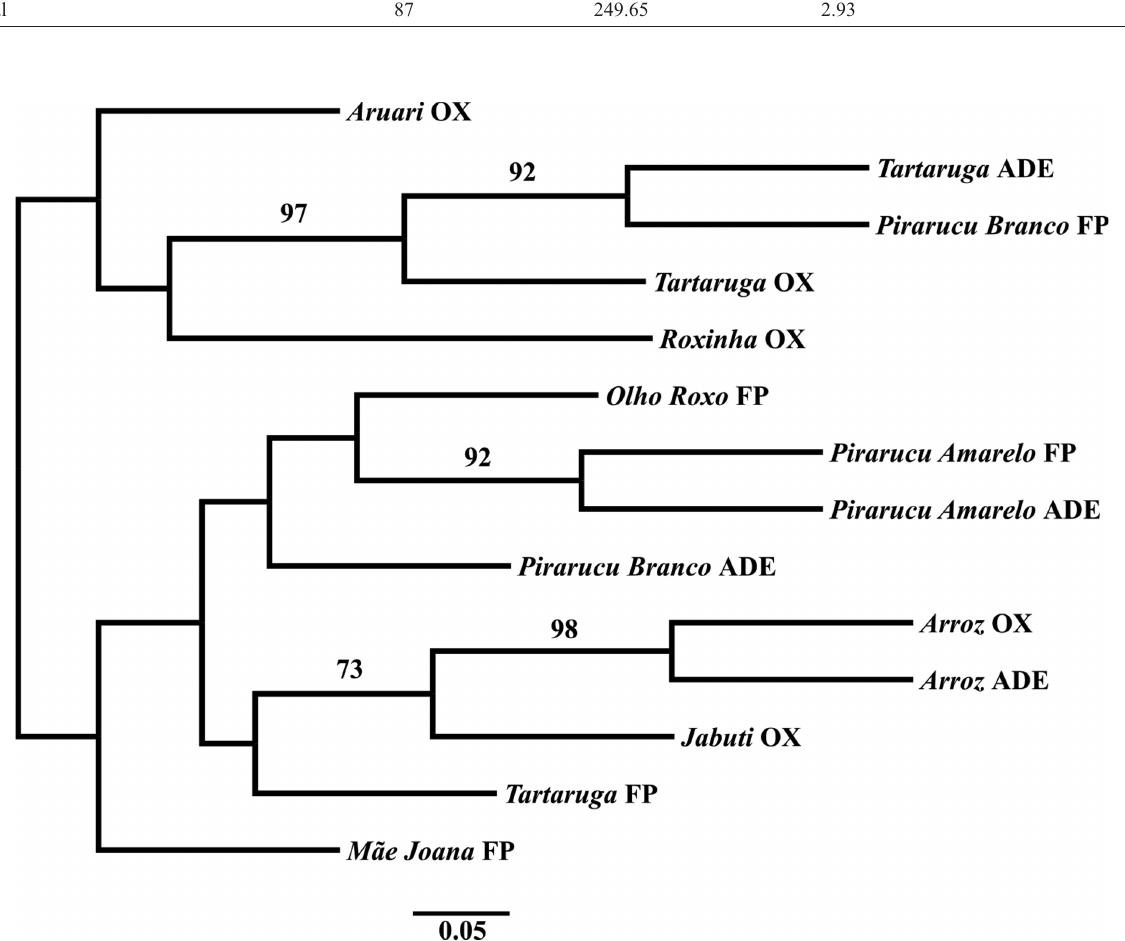
Figure 3 - Neighbor-Joining dendrogram based on the Nei et al . (1983) genetic distance (D A ), showing the relationships among 14 varieties grown in dif- ferent soil types in Manicoré, Amazonas, Brazil. Soil types are coded as ADE (Amazonian dark earths), FP (floodplain) and OX (Oxisols). Bootstrap val- ues greater than 70% are indicated.